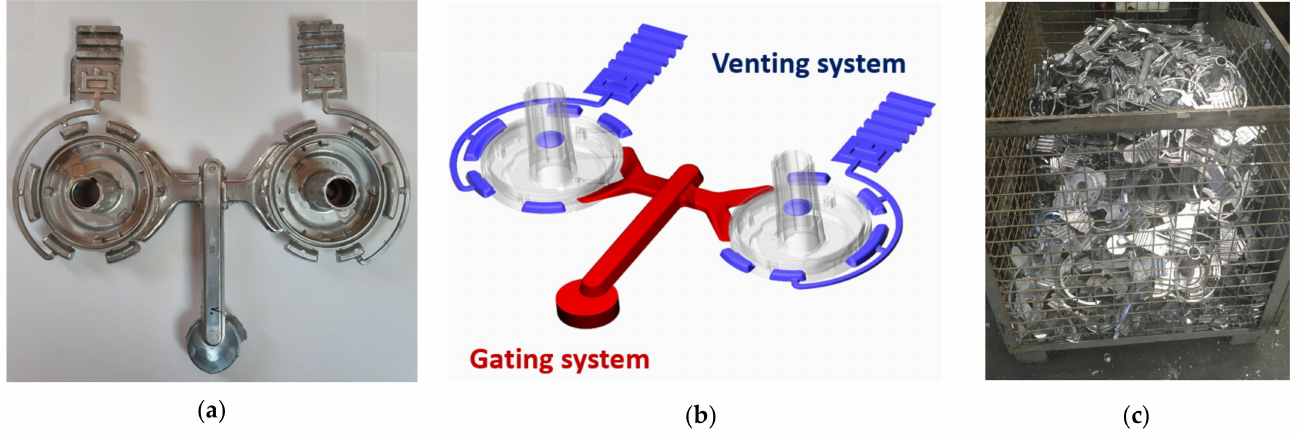
Figure 1. Stator Buchse D 106/70 casting: ( a ) Double-cavity mould; ( b ) 3D model of the casting; ( c ) Returnable material. The subeutectic AlSi9Cu3(Fe) alloy (A226, EN AC–46,000) was used in this